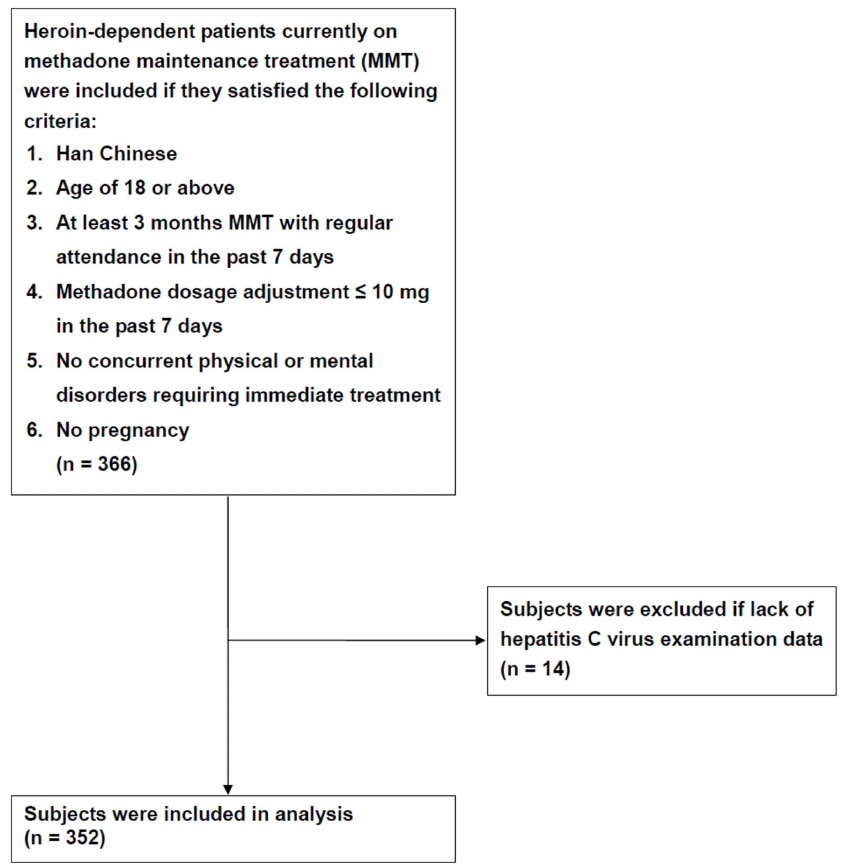
Figure 1. Flow diagram of the study recruitment procedure for MMT patients.